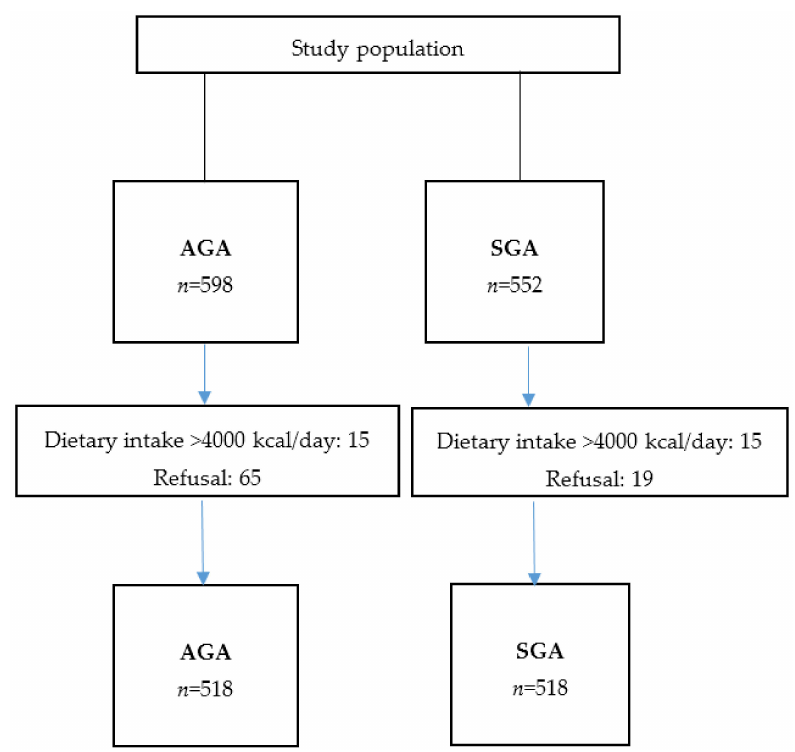
Figure 1. Study population flow